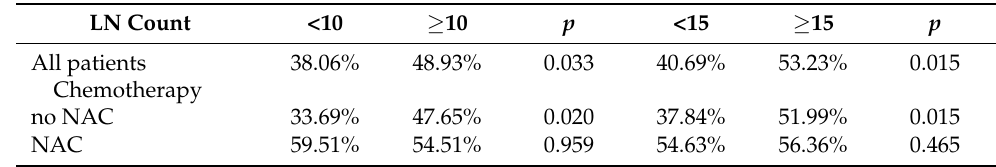
Figure 3. ( A ) Kaplan–Meier analysis of overall survival in chemotherapy-naïve patients who underwent radical cystec- stratified according to lymphadenectomy yield of <10 LNs vs. ≥ 10 LNs and <15 LNs vs. ≥ 15 LNs. ( B ) Kaplan–Meier analysis of overall survival in chemotherapy pre-treated patients who underwent radical cystectomy stratified according to lymphadenectomy yield of <10 LNs vs. ≥ 10 LNs and <15 LNs vs. ≥ 15 LNs. LN: lymph nodes; NAC: neoadjuvant chemotherapy. Table 3. Three-year overall survival of patients who underwent radical cystectomy according to the number of dissected lymph